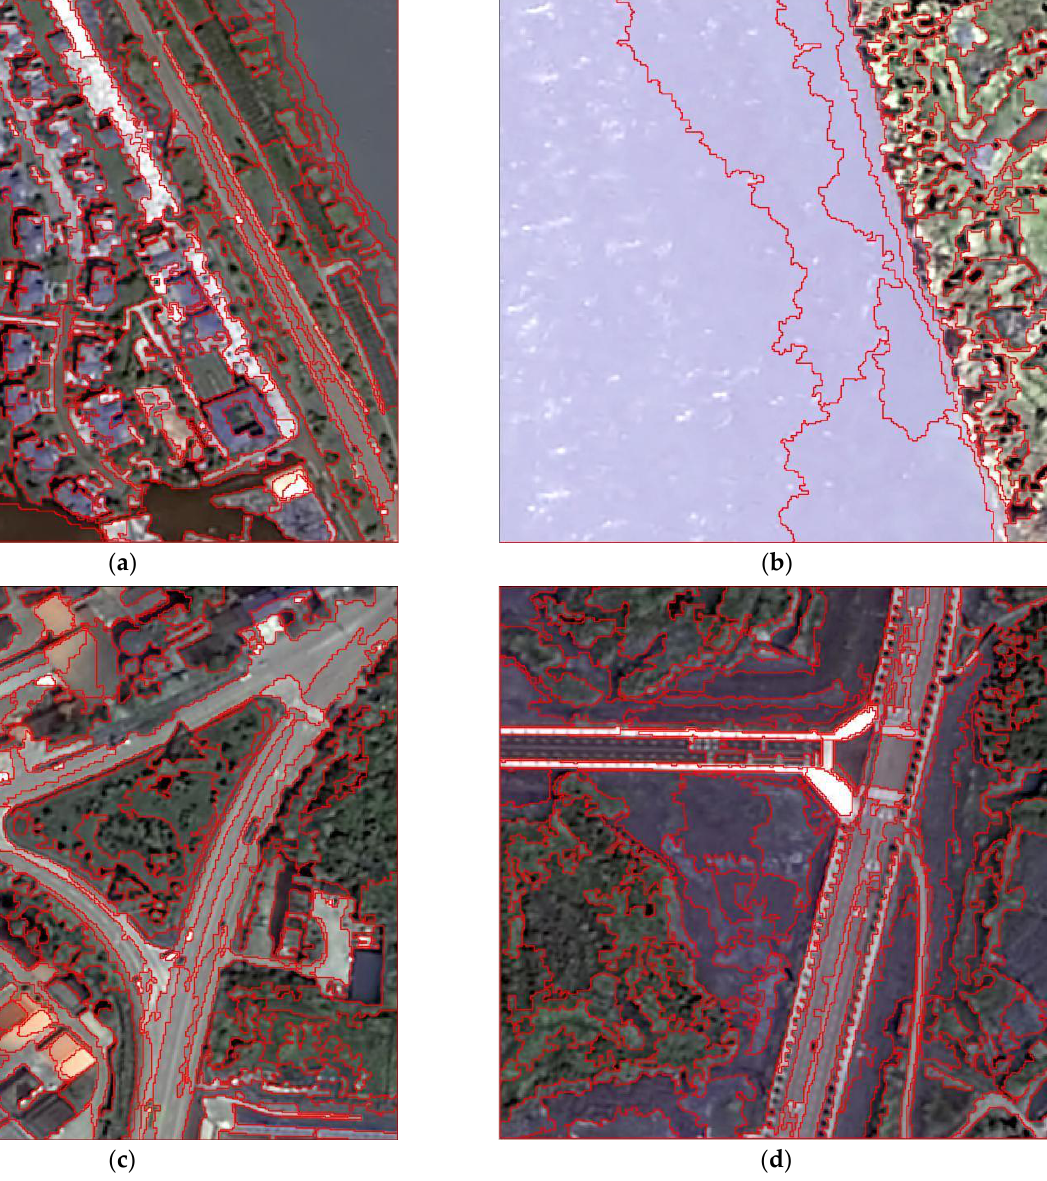
Figure 3. Typical ground object segmentation plot: ( a ) buildings; ( b ) water; ( c ) roads; ( d ) bare land.